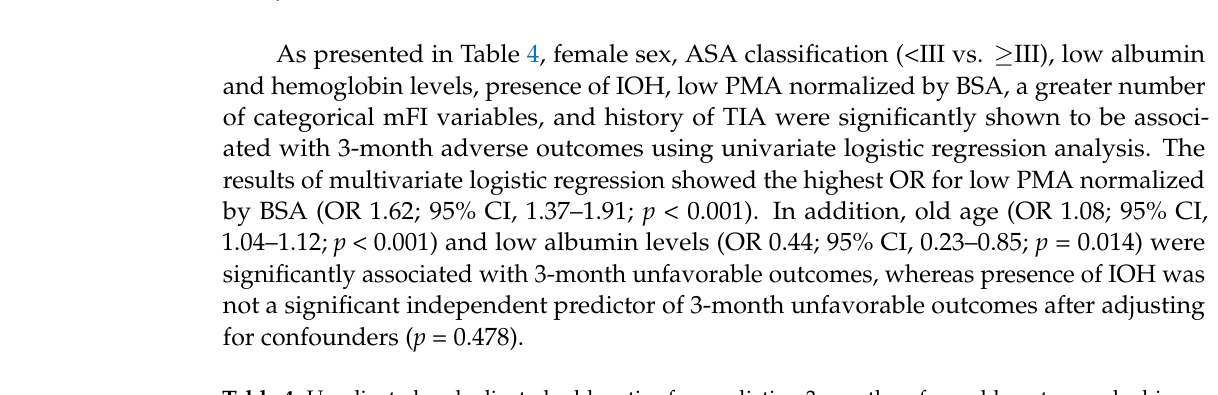
Table 4. Unadjusted and adjusted odds ratios for predicting 3-month unfavorable outcomes by binary logistic